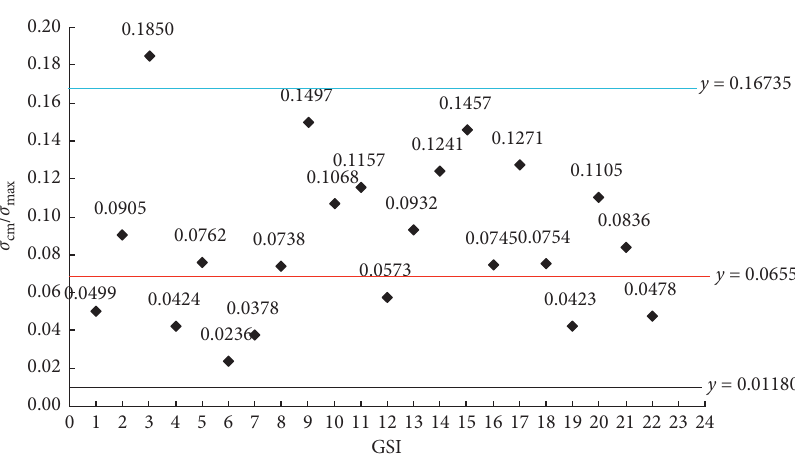
Figure 8: The ratios of σ cm to σ max at various measurement points.